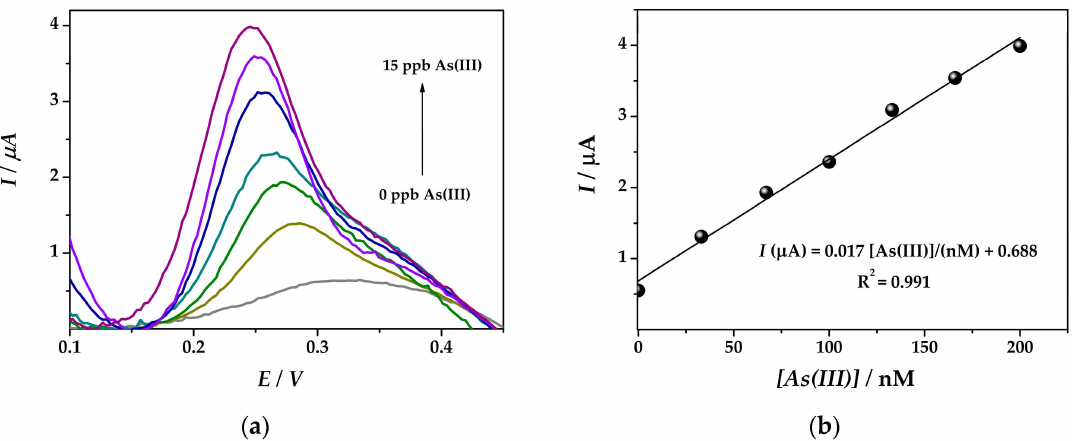
Figure 6. ( a ) SWASV obtained at ( IV )Au-PtNPs / SPCE platform ( E dep = − 0.5 V; t dep = 60 s) with arsenic solution concentrations of 33, 67, 100, 133, 166, 200 nM As(III) in 0.1 M HCl solution and ( b ) the corresponding calibration plot.